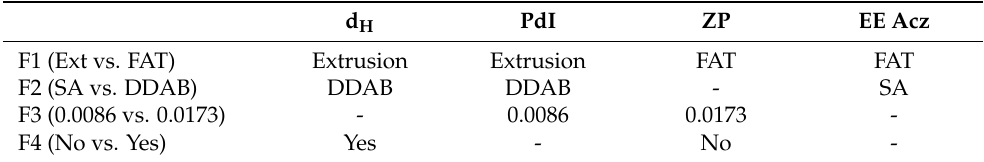
the different responses in the sense of minimizing d H (size) and maximizing PdI (polydispersity